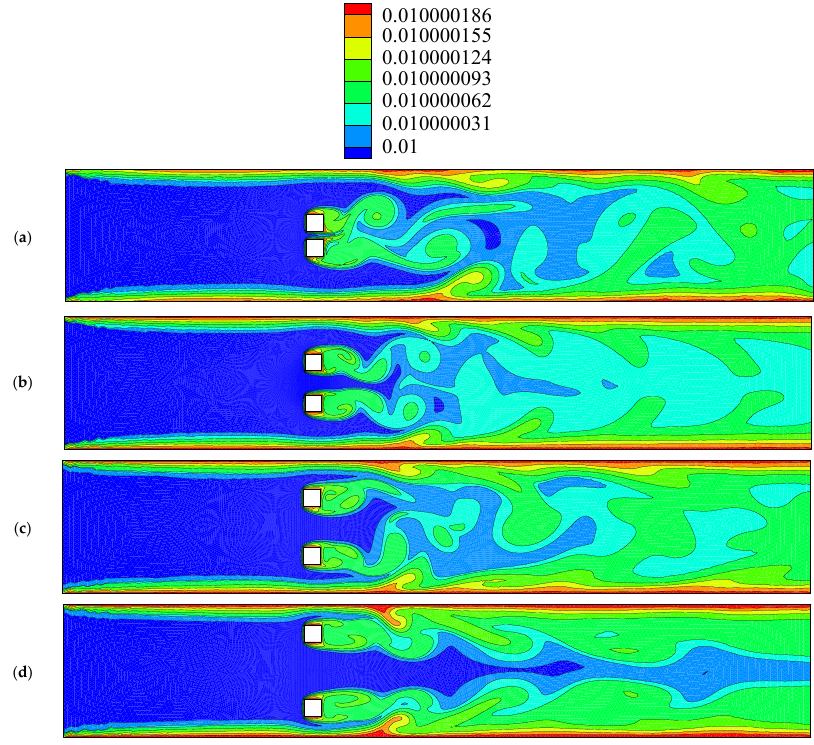
Figure 6. Concentration contours for ( a ) S/D = 1.5; ( b ) S/D = 2.5; ( c ) S/D = 3.5; ( d ) S/D = 4.5 at Re = 100, d p =30 nm, and Φ = 0.01.